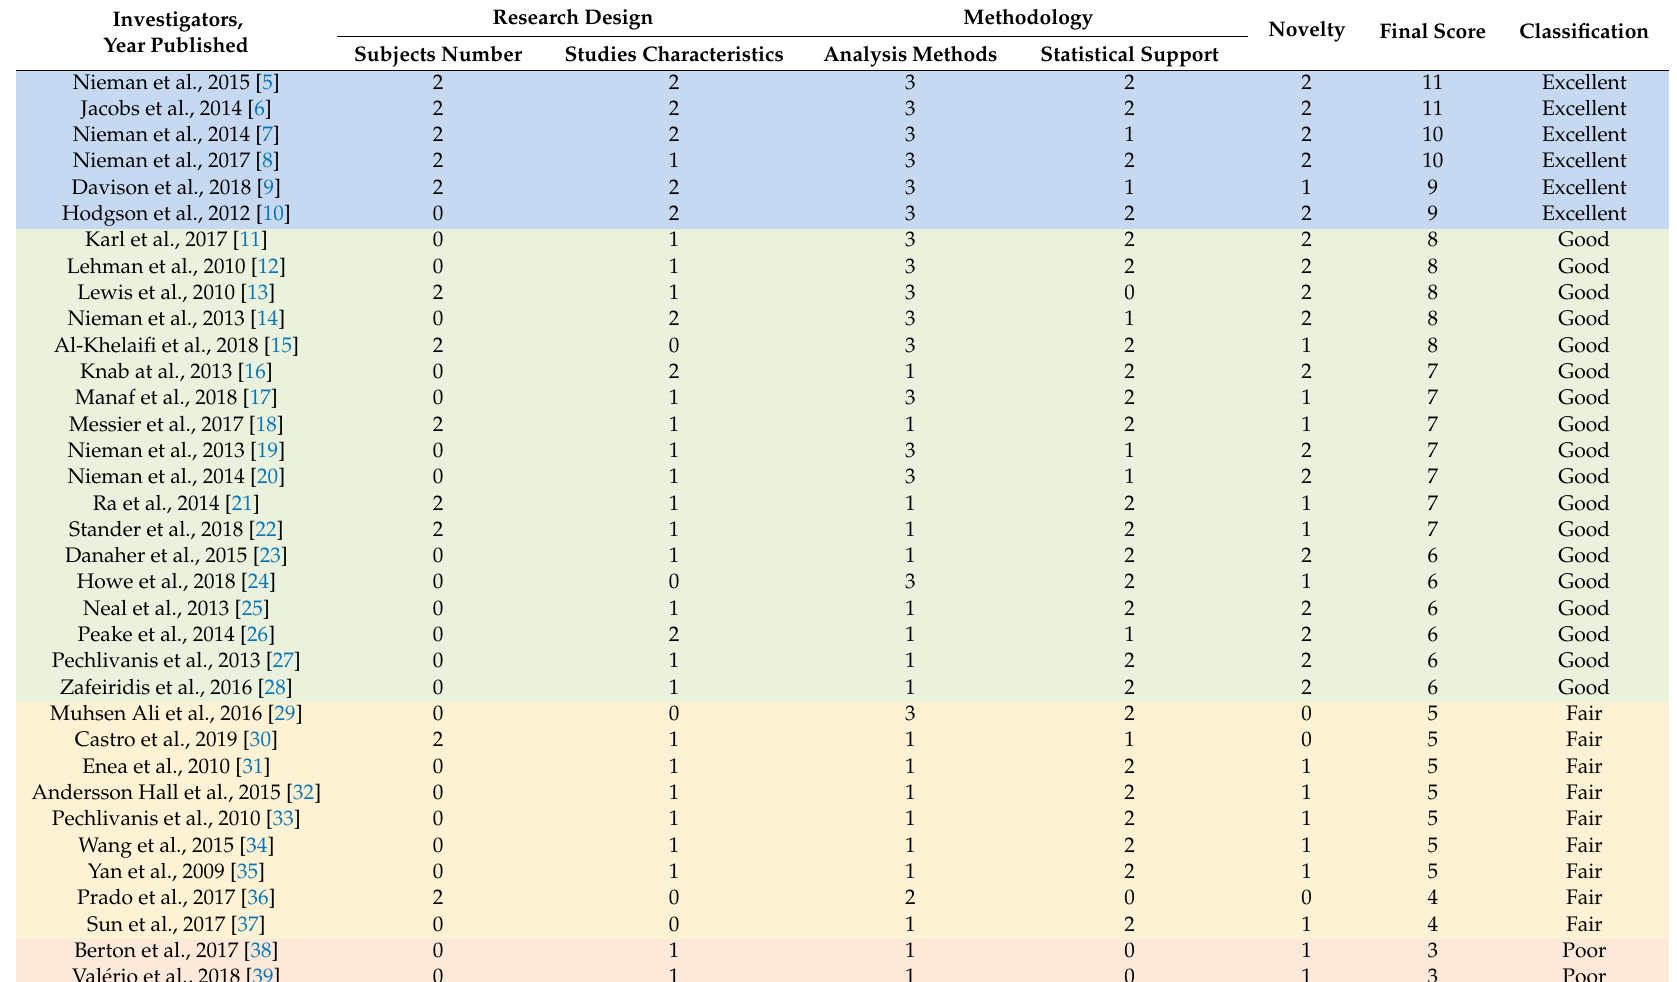
Table 1. Studies classification according to score